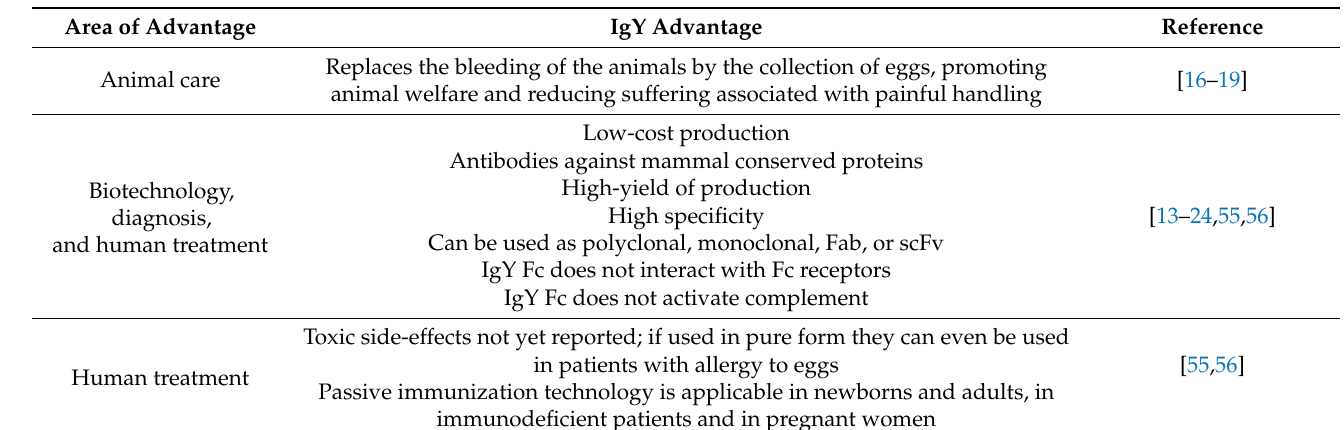
Table 1. IgY technologies show advantages compared to antibodies from